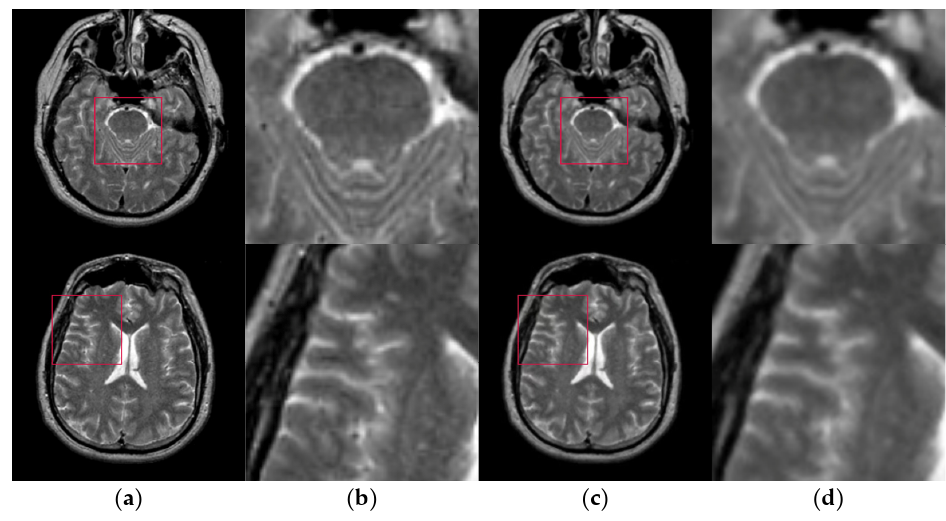
Figure 6. An example of hybrid spatial filter. ( a ) Original images, ( b ) Part of the enlarged original images ( c ) The results obtained by hybrid spatial filter, ( d ) Part of the enlarged results images.